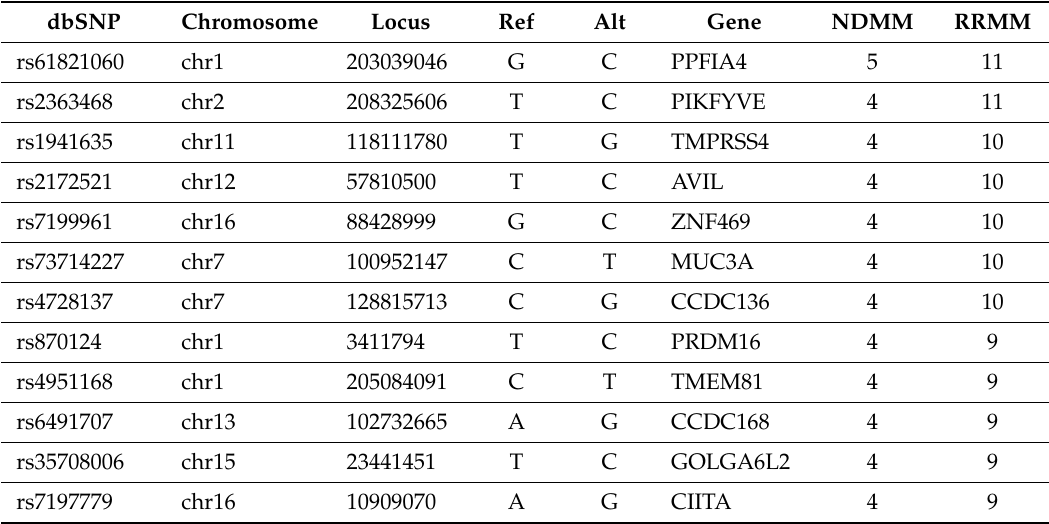
Figure 3. SNP and indel analysis. ( A ) Identification of SNPs in MM and their annotation. ( B ) Comparison of the distribution and the frequency of mucin gene mutations in NDMM and RRMM. ( C ) Identification of small indels in NDMM and RRMM. ( D ) Annotation of 13 known small indels specific to NDMM. Table 3. Common nonsynonymous SNPs identified in NDMM and RRMM. The number of NDMM and RRMM patients were